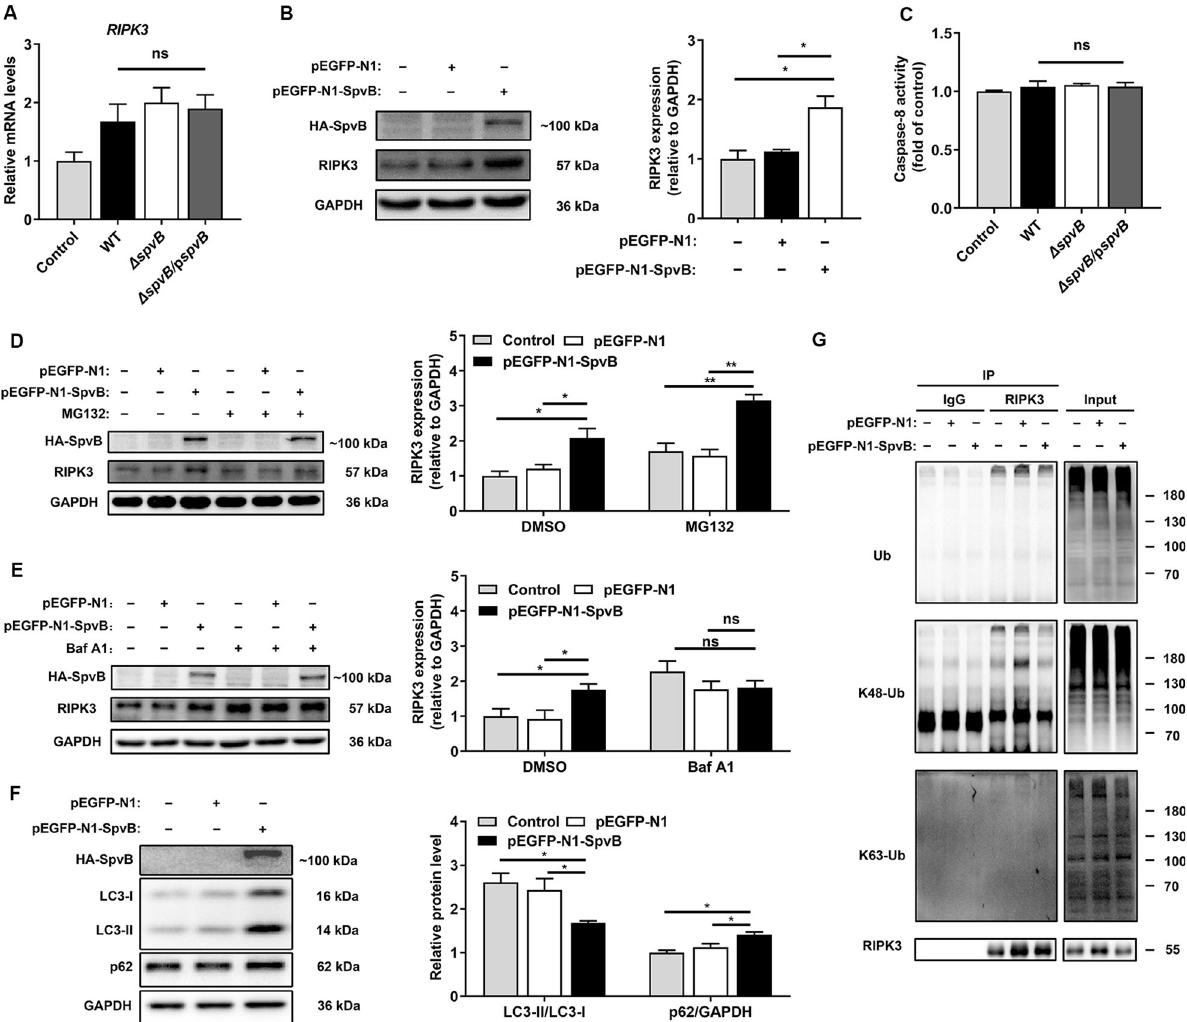
Fig. 4 SpvB leads to epithelium necroptosis through inhibiting RIPK3 ubiquitination and autophagy-dependent degradation. A , C Caco-2 cells were then infected with WT, Δ spvB , or Δ spvB /p spvB S . Typhimurium strain (MOI of 100) and incubated for 4 h. A RIPK3 levels were determined by RT-qPCR. Values were normalized to those of the housekeeping gene β ‐ ACTIN and fold ‐ changes relative to the untreated control were shown. C Cells were harvested and subjected to measurement of caspase-8 activity. B , D – G Caco-2 cells were transiently transfected with pEGFP-N1-SpvB or pEGFP-N1 for 24 h. B Western blot analysis of the expression of RIPK3. D Cells were treated with 5 μ M MG132 for 24 h and western blot analysis of the expression of RIPK3. E Cells were treated with 100 nM ba fi lomycin A1 (Baf A1) and